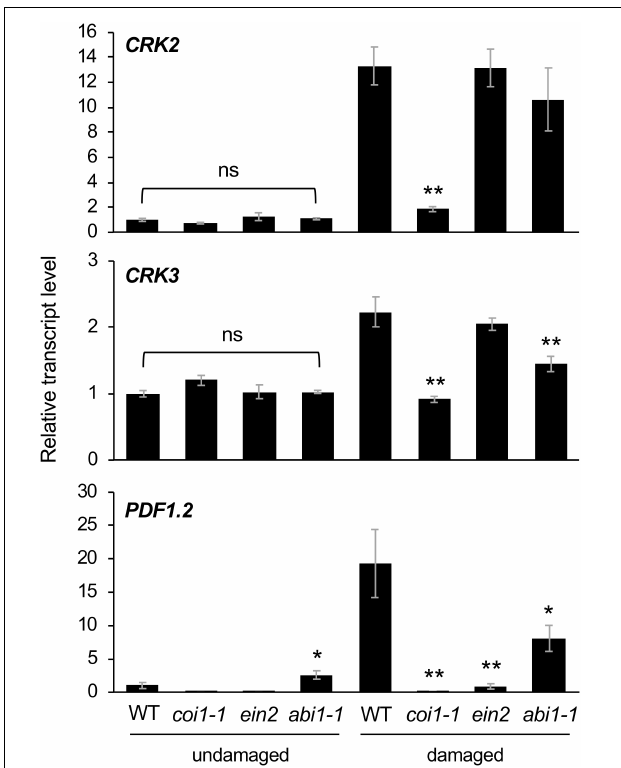
FIGURE 5 | Transcriptional regulation of CRKs in infested leaves. Transcript levels of CRK2 , CRK3 , and PDF1.2 in leaves of Arabidopsis wild-type (WT), coi1-1 , abi1-1 , and ein2 plants damaged or not with S. litura larvae for 24 h. Transcript levels of genes were measured by RT-qPCR and normalized by those of ACT8 . Data represent the mean and standard error ( n = 5–8). Data marked with an asterisk are significantly different from those of undamaged or damaged WT plants, based on a one-way ANOVA with Holm’s sequential Bonferroni post hoc test ( ∗∗ 0.001 ≤ P < 0.01, ∗ 0.01 ≤ P < 0.05). ns, not